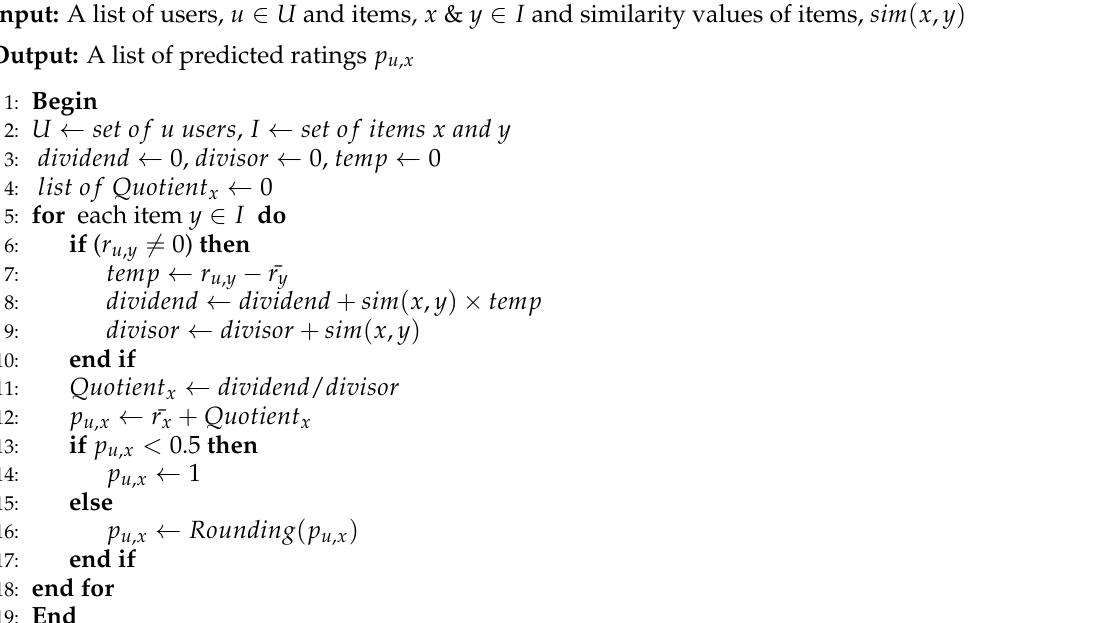
Algorithm 1 : Enhanced Prediction